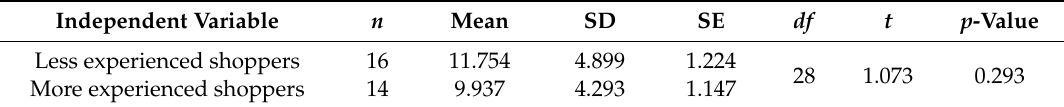
Table 20. Independent t -test results for the product search